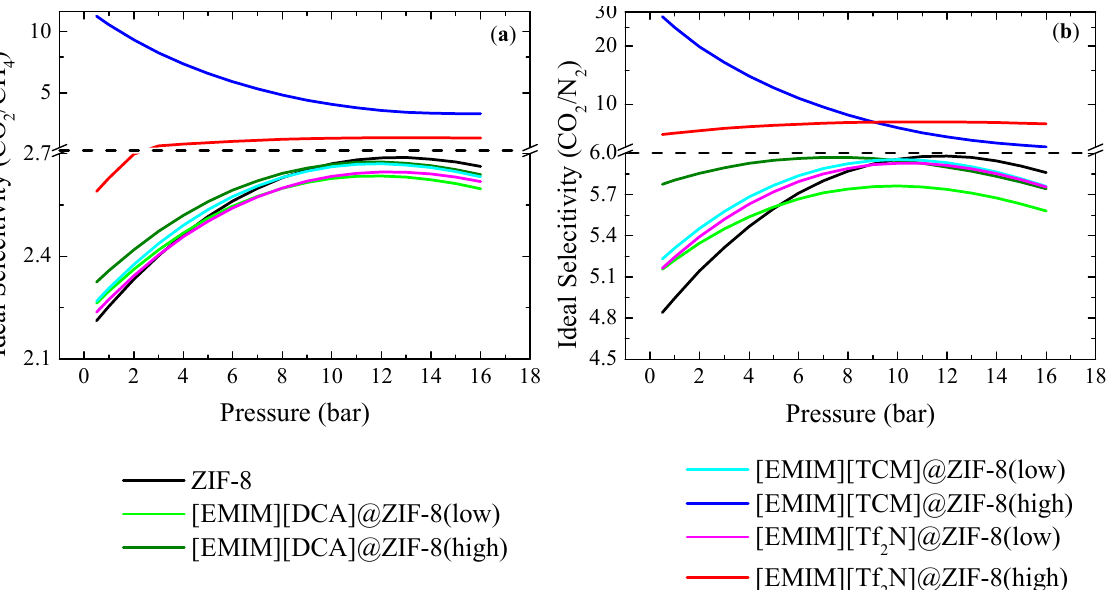
Figure 4. ( a ) Ideal CO 2 /CH 4 and ( b ) CO 2 /N 2 selectivities for ZIF-8 and the produced IL@ZIF-8 composites, considering 50:50 mixture